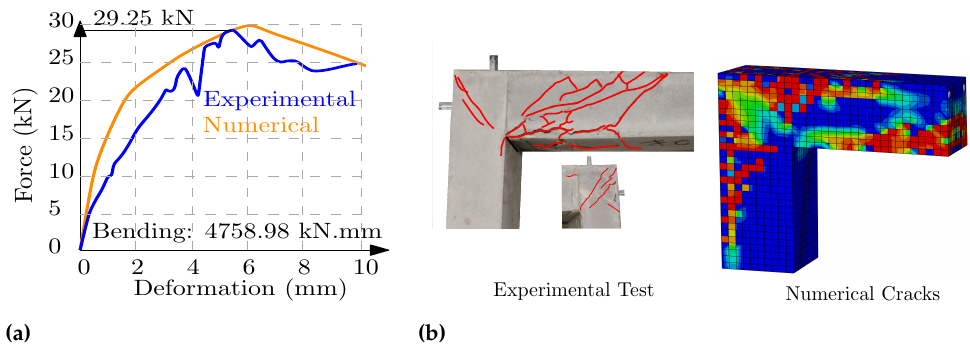
Figure 4. F0, ( a ) Force–deformation, ( b ) experimental cracking and numerical cracking pattern.